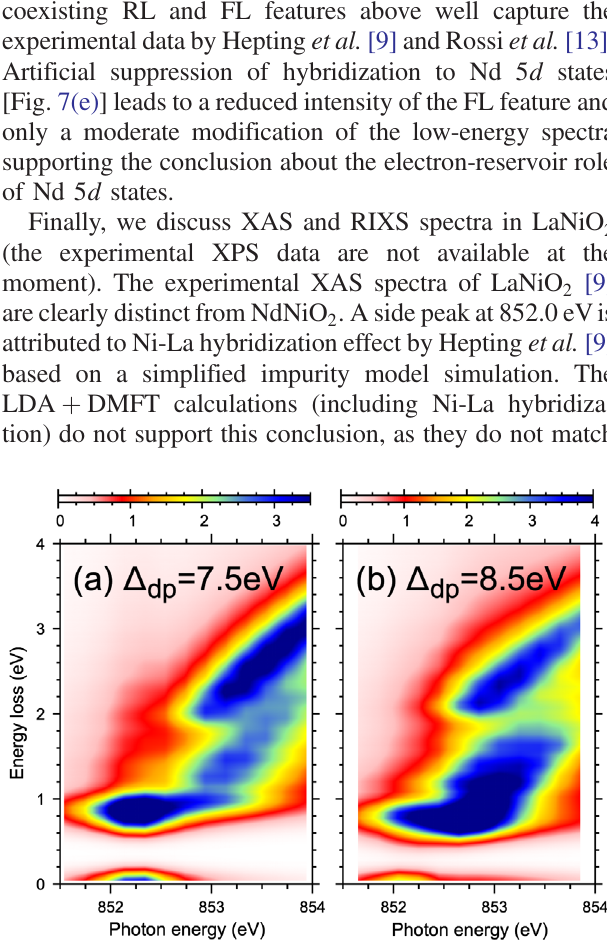
FIG. 7. The Ni L 3 RIXS spectra of NdNiO 2 calculated for (a) Δ 6 . 9 eV. (e) The Ni L (d) Δ 3 RIXS spectra calculated for the model without the hybridization between Nd dp ¼ 4 . 9 eV). The spectral broadening is considered using a Gaussian of 100 meV (HWHM). plane ( Δ dp ¼